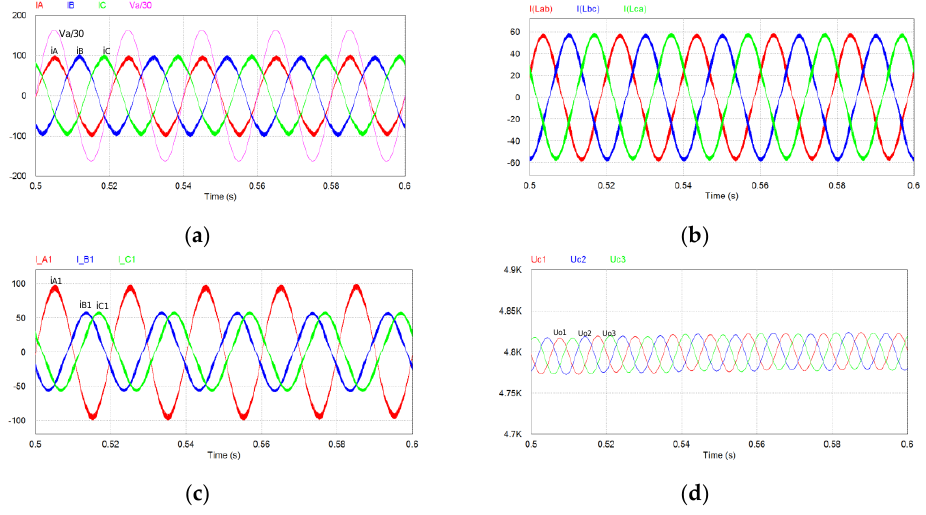
Figure 9. Simulation waveforms. ( a ) the grid line currents. ( b ) the delta connected inner currents. ( c ) the ac-side currents of the VIENNA rectifier unit 1. ( d ) the dc-link voltages of three VIENNA units.